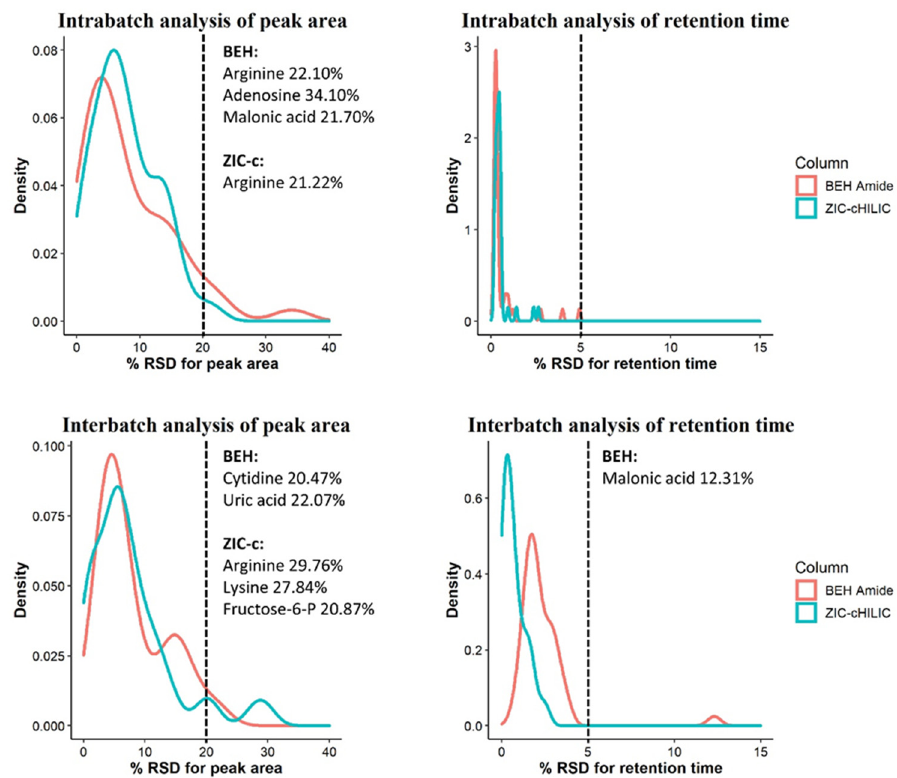
Figure 4. Repeatability evaluation of peak areas and retention times of 42 representative compounds during inter- and intra-batch analysis using ZIC-c HILIC and BEH-amide columns. Metabolite names with an RSD above 20% are listed on the right side of the cut-off line.